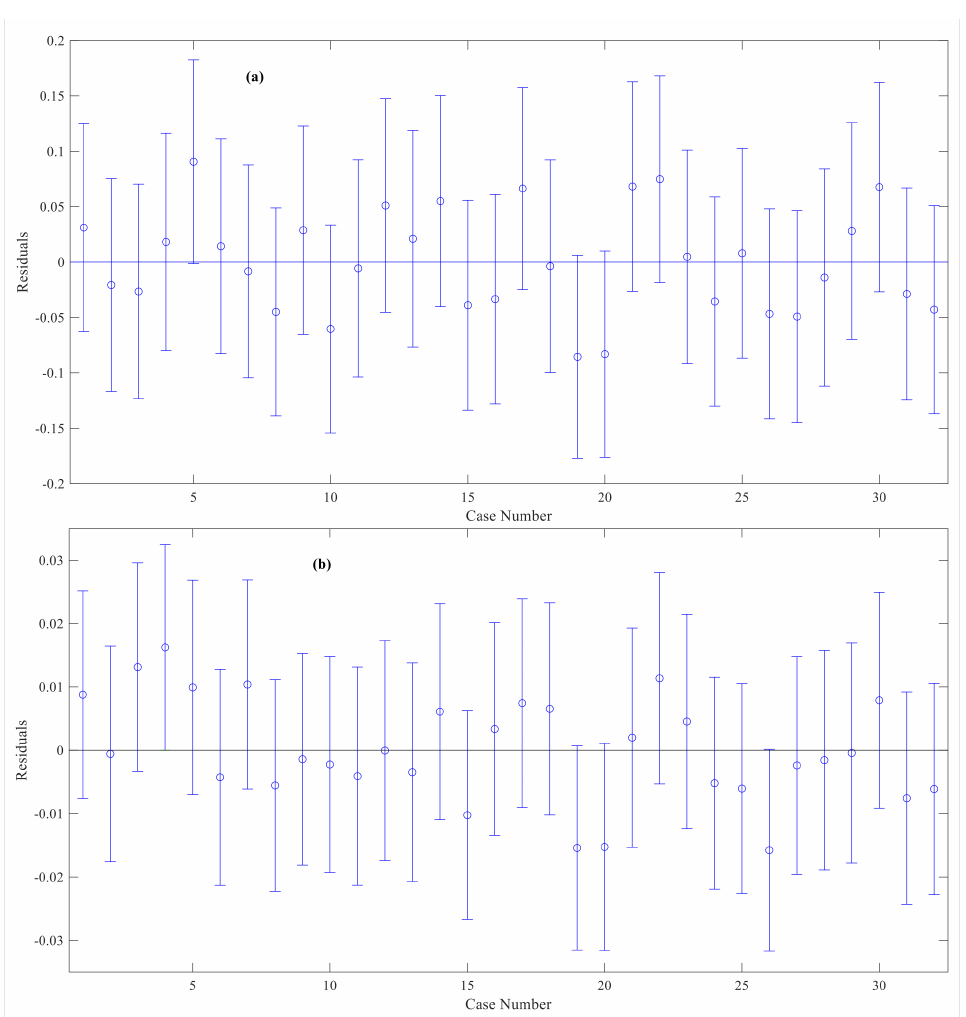
Figure 15. The residual plot of ( a ) normal and ( b ) information spread distributions for the median pore